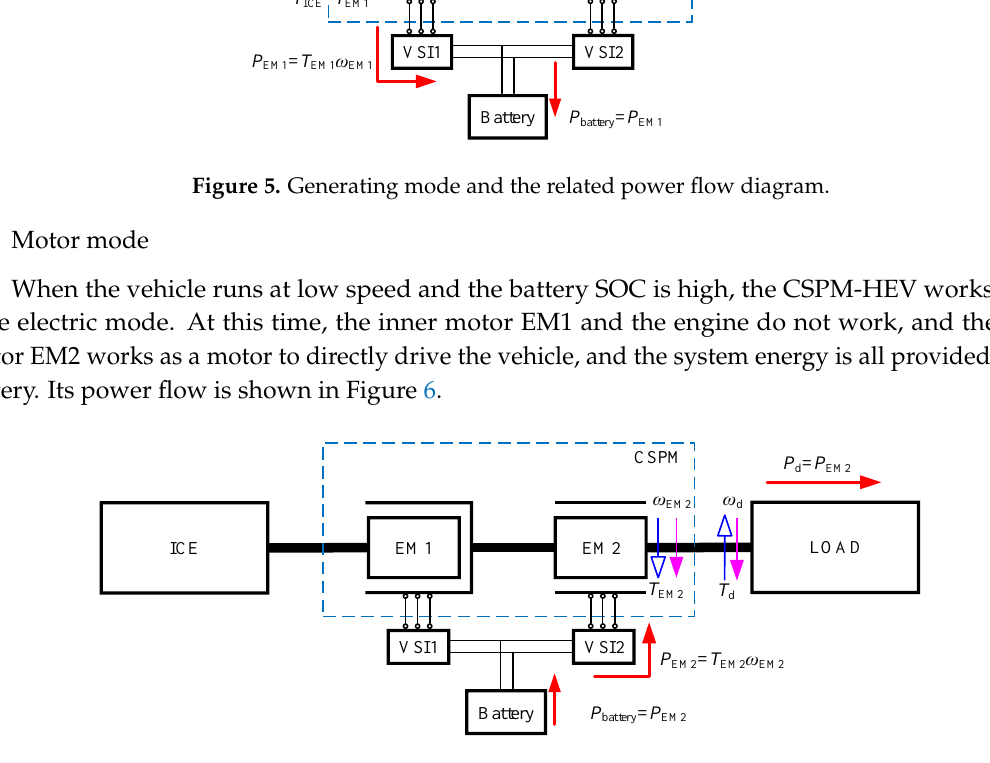
Figure 6. Motor mode and the related power flow diagram.